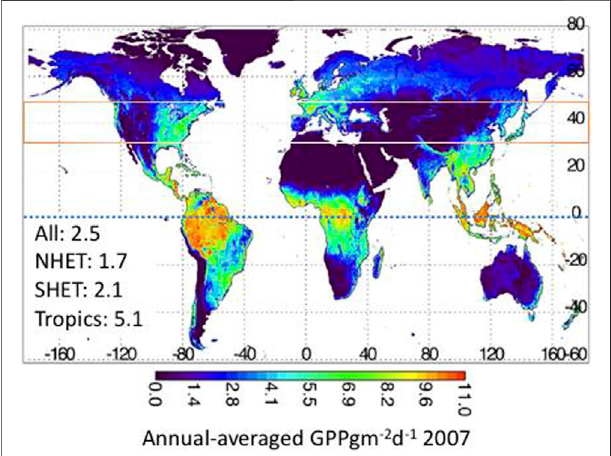
FIGURE 8 | Global map of annual averaged Gross Primary Production (GPP) estimated with remote sensing data for the year 2007. The means are listed in the lower left corner for all grid boxes (All), along with subsets from the Tropics (latitudes < 20 ° ). Northern Hemisphere Extra Tropics (NHET: latitudes > 20 ° N)andSouthernHemisphereextra-tropics(latitudesbelow20 ° S (SHET) (Joiner et al., 2018; Yoshida, Y.; Zhang et al., 2018) republished under creative